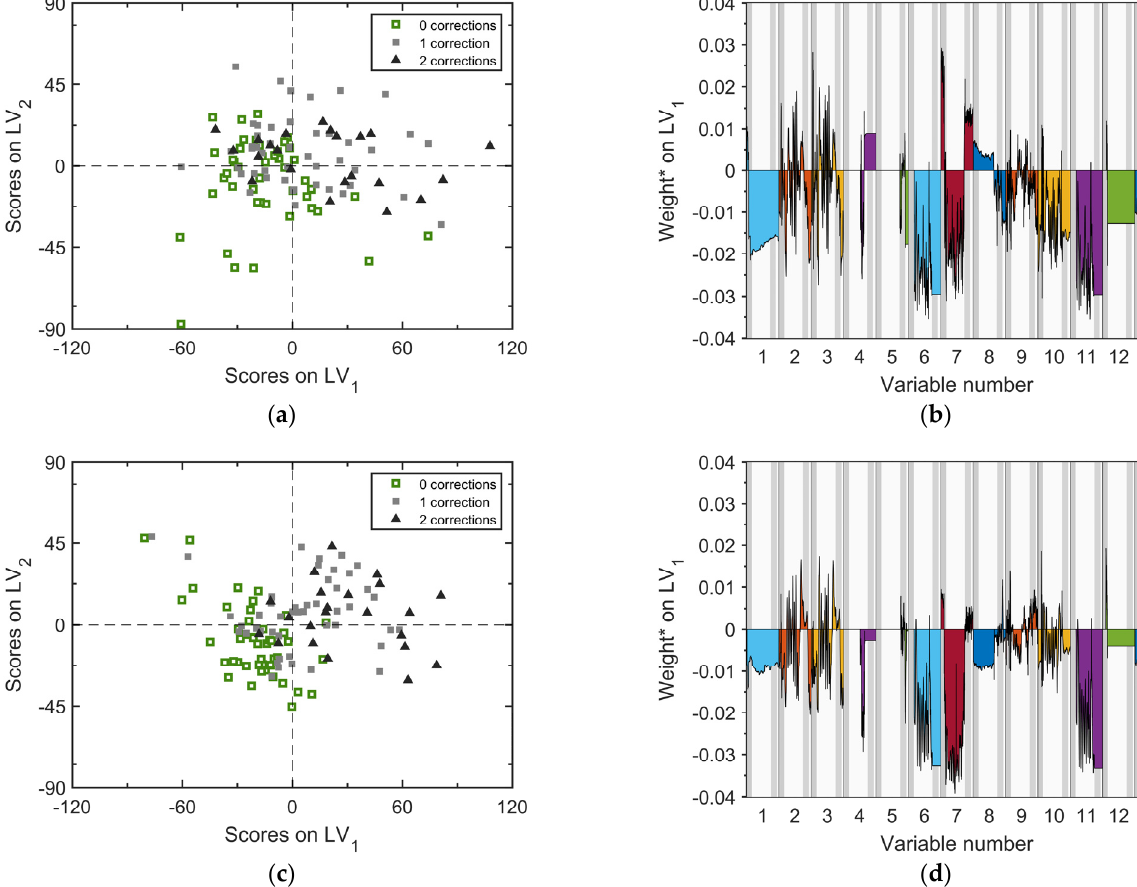
Figure 7. Two-component PLS-DA model for R201. ( a , c ) are the scores plots for Step A and Step B, respectively (each marker represents a charge to R201, and the different shapes of the markers denote a different number of corrections eventually required). ( b , d ) are the time trajectories of the weights for the first latent variable for each process variable for Step A and Step B, respectively (the variable numbering is reported in the Appendix A). For each variable in ( b , d ), the first grey-shaded area represents reactant C charging stage, the subsequent white-shaded area is the reactants D and W charging stage, the subsequent grey-shaded area is the additive O charging stage, and the final white-shaded area is the final transfer stage.